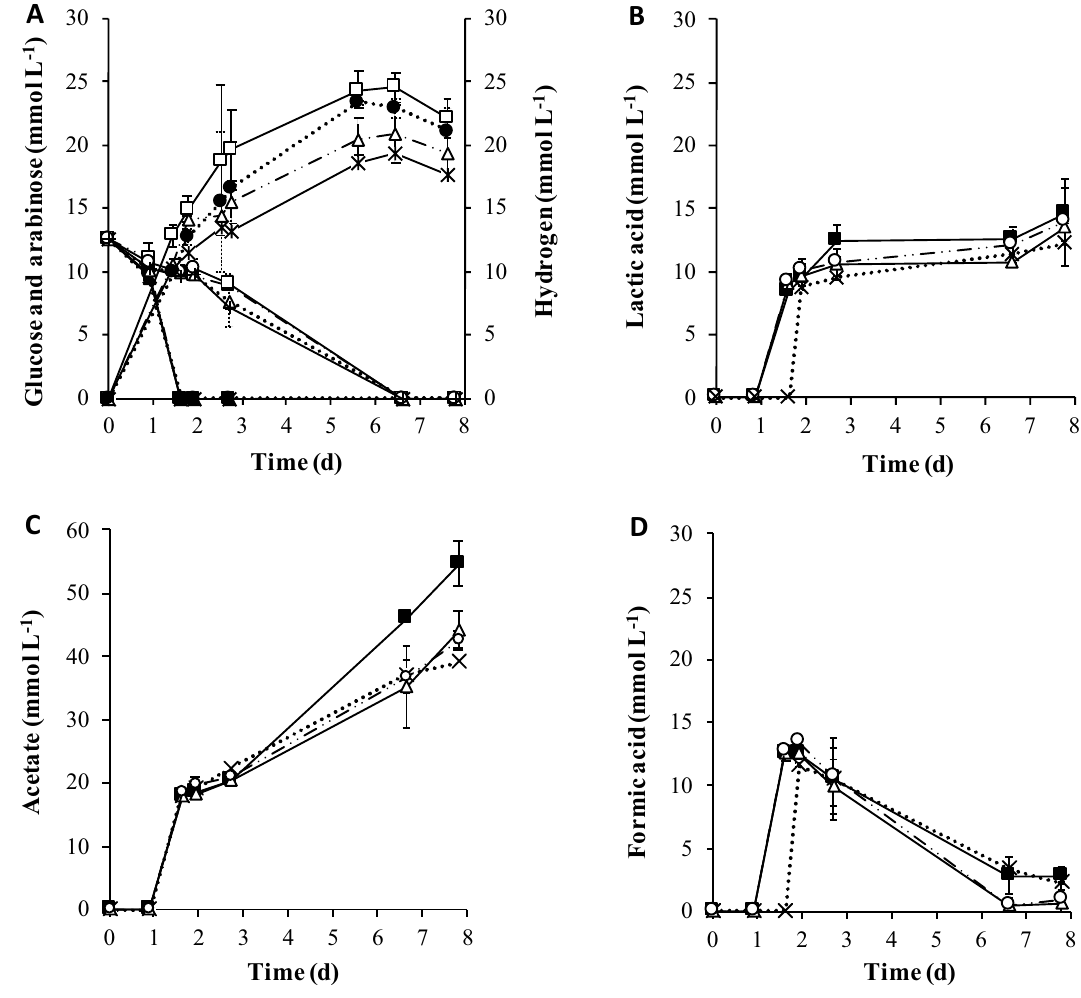
Figure 1. Cumulative hydrogen production and fermentative products produced in the batch assay with different zeolite to inoculum (in VS) ratios (0.26, 0.13, 0.065 g g −1 ) and for the control (without zeolite). ( A ) Glucose consumption: …….. 0.26 g g −1 ; ……… 0.13 g g −1 ; ……… 0.065 g g −1 ; ……. control. Arabinose consumption: ………. 0.26 g g −1 ; ……… 0.13 g g −1 ; …… 0.065 g g −1 ; ……. control. Hydrogen production: …….. 0.26 g g −1 ; …….. 0.13 g g −1 ; ……´. 0.065 g g −1 ; ……. control. ( B ), ( C ) and ( D ) Lactic acid, Acetic acid and formic acid production, respectively: …… 0.26 g g −1 ; …….. 0.13 g g −1 ; ……… 0.065 g g −1 ; .……. control. The results are the average and standard deviations for duplicate assays.